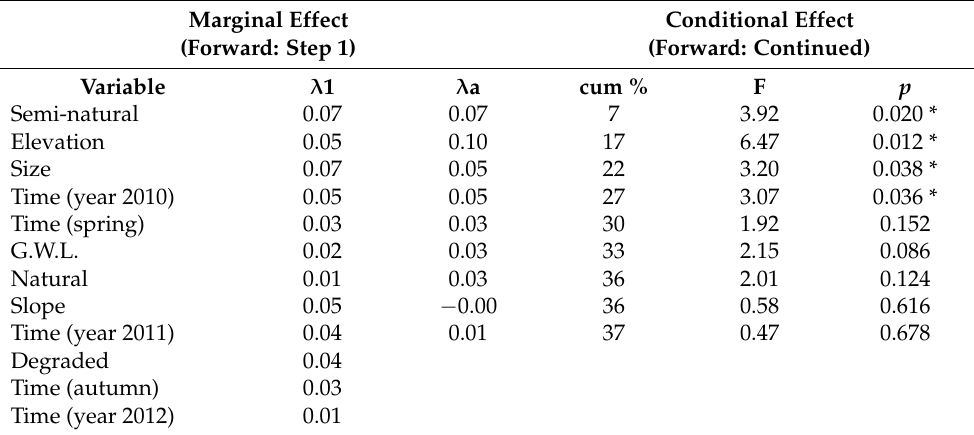
Table 7. Ranking environmental variables by importance according to marginal and conditional effects based on the Lumbricidae traits pattern in the mountain fen Caltho-Alnetum sites by auto- matic forward selection in RDA. RDA model calculated with log 10 (x + 1)-transformed species traits data. λ 1 = fit = eigenvalue with only one variable; λ a = additional fit = increase in eigenvalue; cum %—explained cumulative % of eigenvalues; F—value of the F-ratio statistic; p —significance level of the conditional effect tested by unrestricted Monte Carlo permutation test under the reduced model with 499 permutations; G.L.W.—groundwater